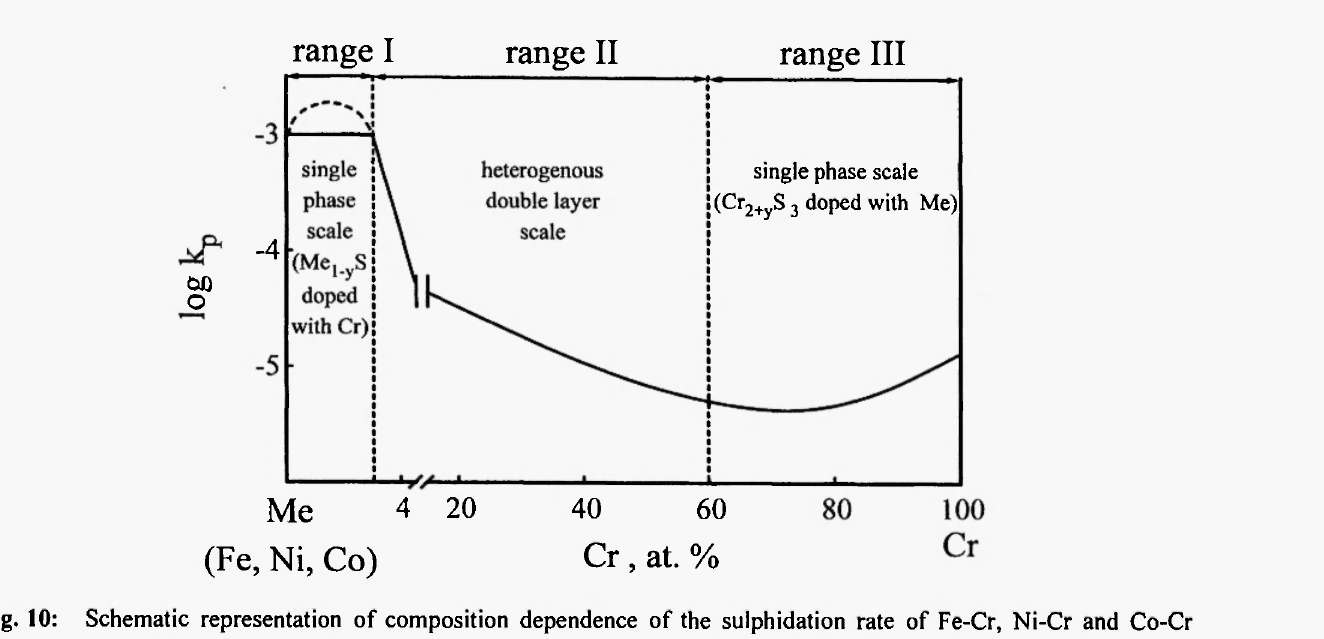
Fig. 10: Schematic representation of composition dependence of the sulphidation rate of Fe-Cr, Ni-Cr and Co-Cr alloys /8/.